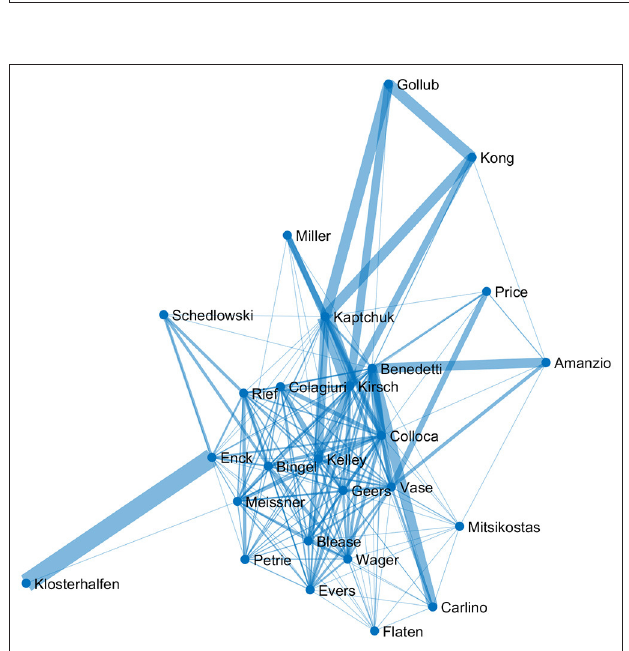
FIGURE 5 | Network of the most prolific authors in the JIPS database. Cutoff criterion for inclusion were ≥ 25 publications included in the database. Line width indicates the weight of the connection, corresponding to the number of shared publications. Centrality indicates the number of interconnected researchers.